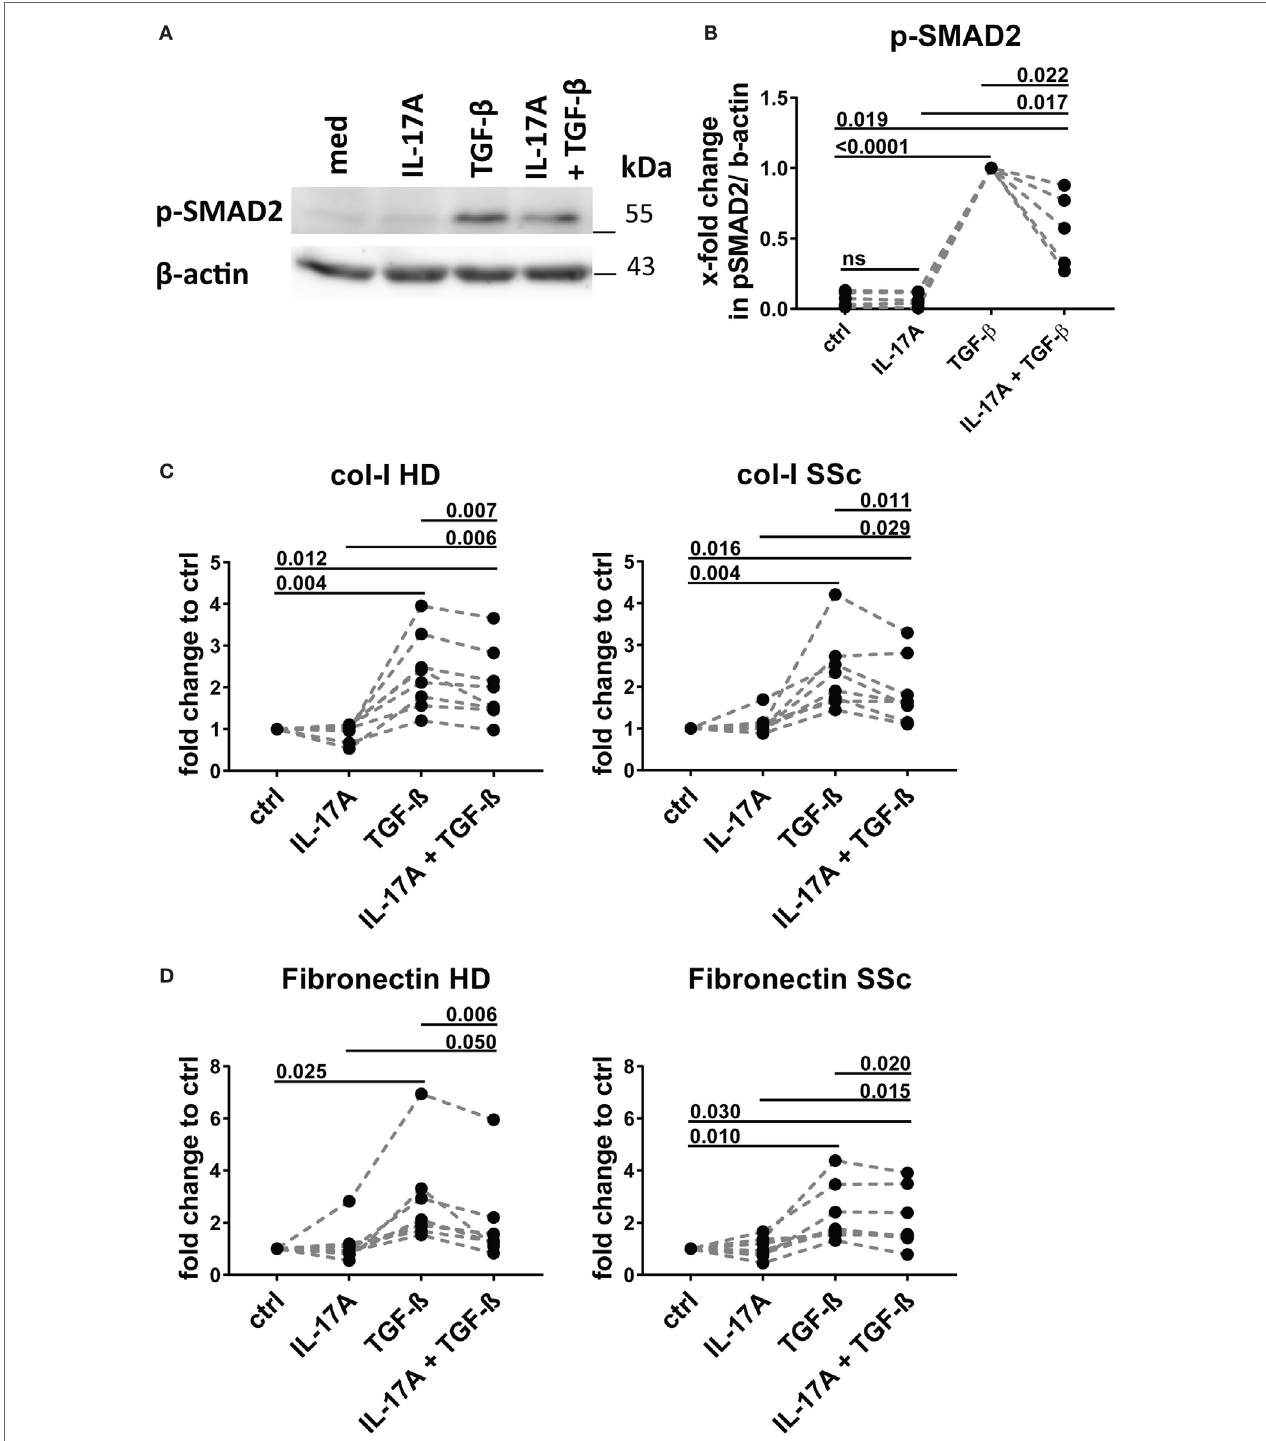
FigUre 7 | IL-17A inhibits SMAD2 phosphorylation and production of type I collagen and fibronectin induced by TGF- β . Healthy donors (HD) fibroblasts were treated with IL-17A (25 ng/ml) and/or TGF- β (2.5 ng/ml) for 10 min. (a) . Western blot (WB) representative of five distinct experiments. (B) Quantification of WB analysis. Results are shown as fold change to TGF- β -treated cells, N = 5. (c,D) Primary human fibroblasts from HD (left panel) and systemic sclerosis (SSc) patients (right panel) in triplicates were treated with IL-17A (25 ng/ml), TGF- β (2.5 ng/ml), or a combination of these cytokines. After 48 h, culture supernatants were collected and type I collagen (c) and fibronectin (D) levels were assessed by ELISA ( N = 5). Results are shown as fold change to untreated cells. Basal levels for col-I were 364.8 ( ± 91.0) and 203.8 ( ± 66.5) ng/ml and for fibronectin 972.7 ( ± 273.9) and 1036,4 ( ± 307.6) ng/ml, in HD and SSc, respectively. Significance was assessed by paired t